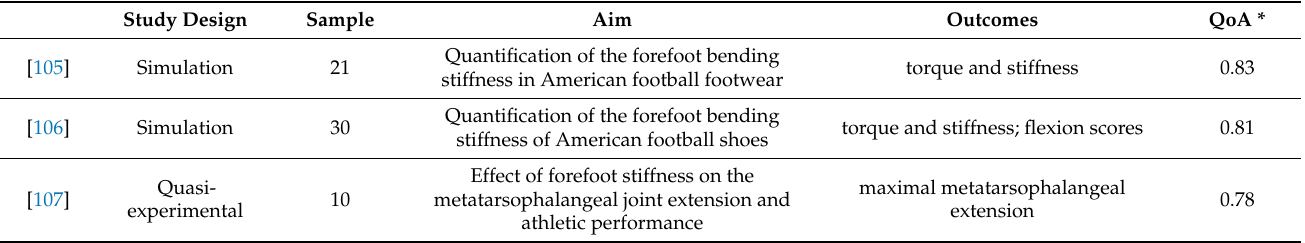
Table 6. Studies regarding the biomechanics of